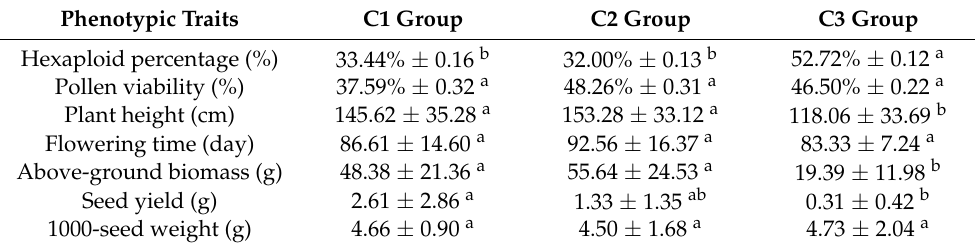
Table 2. Phenotypic variation among three different groups (C1, C2 and C3 goup) in S 2 generation derived from a hexaploid Brassica hybrid